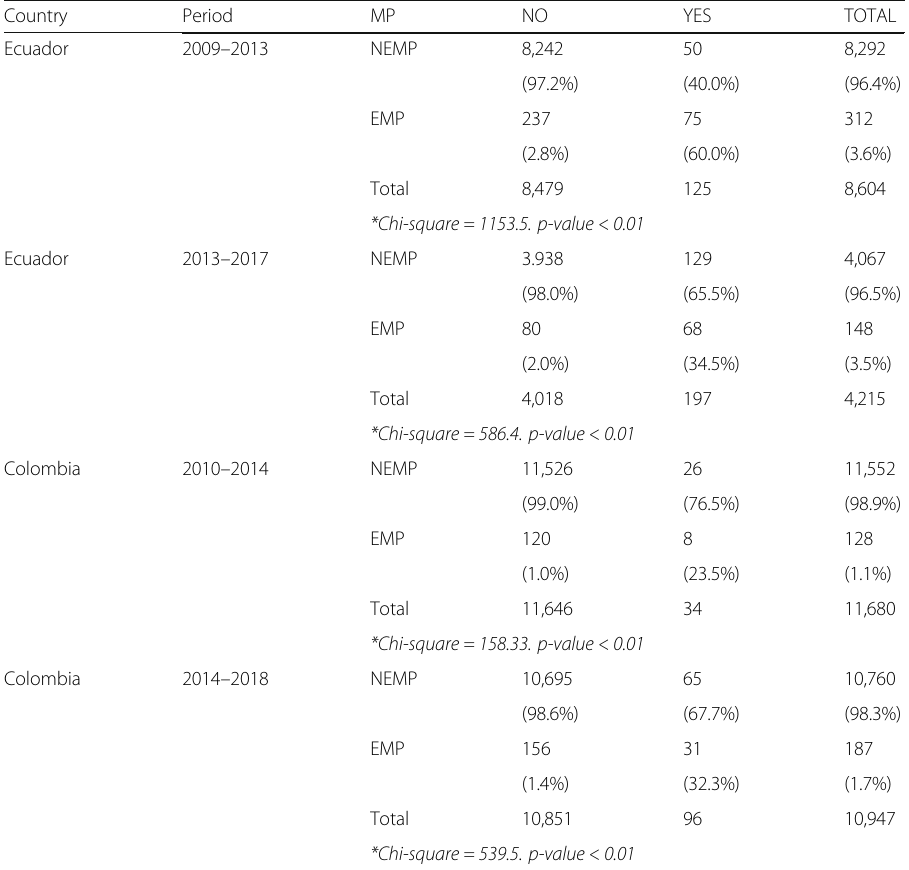
Table 5 Speeches explicitly related to emigrant issues classified by migrant background (Ecuador and Colombia). Total number and column percent. Source: Author ’ own Country